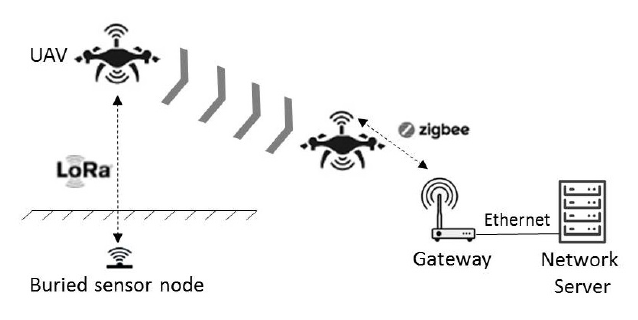
Figure 2. Principle scheme. The Lora technology is used to retrieve the data from the buried sensor nodes, and the Zigbee communication is used to upload the data on the